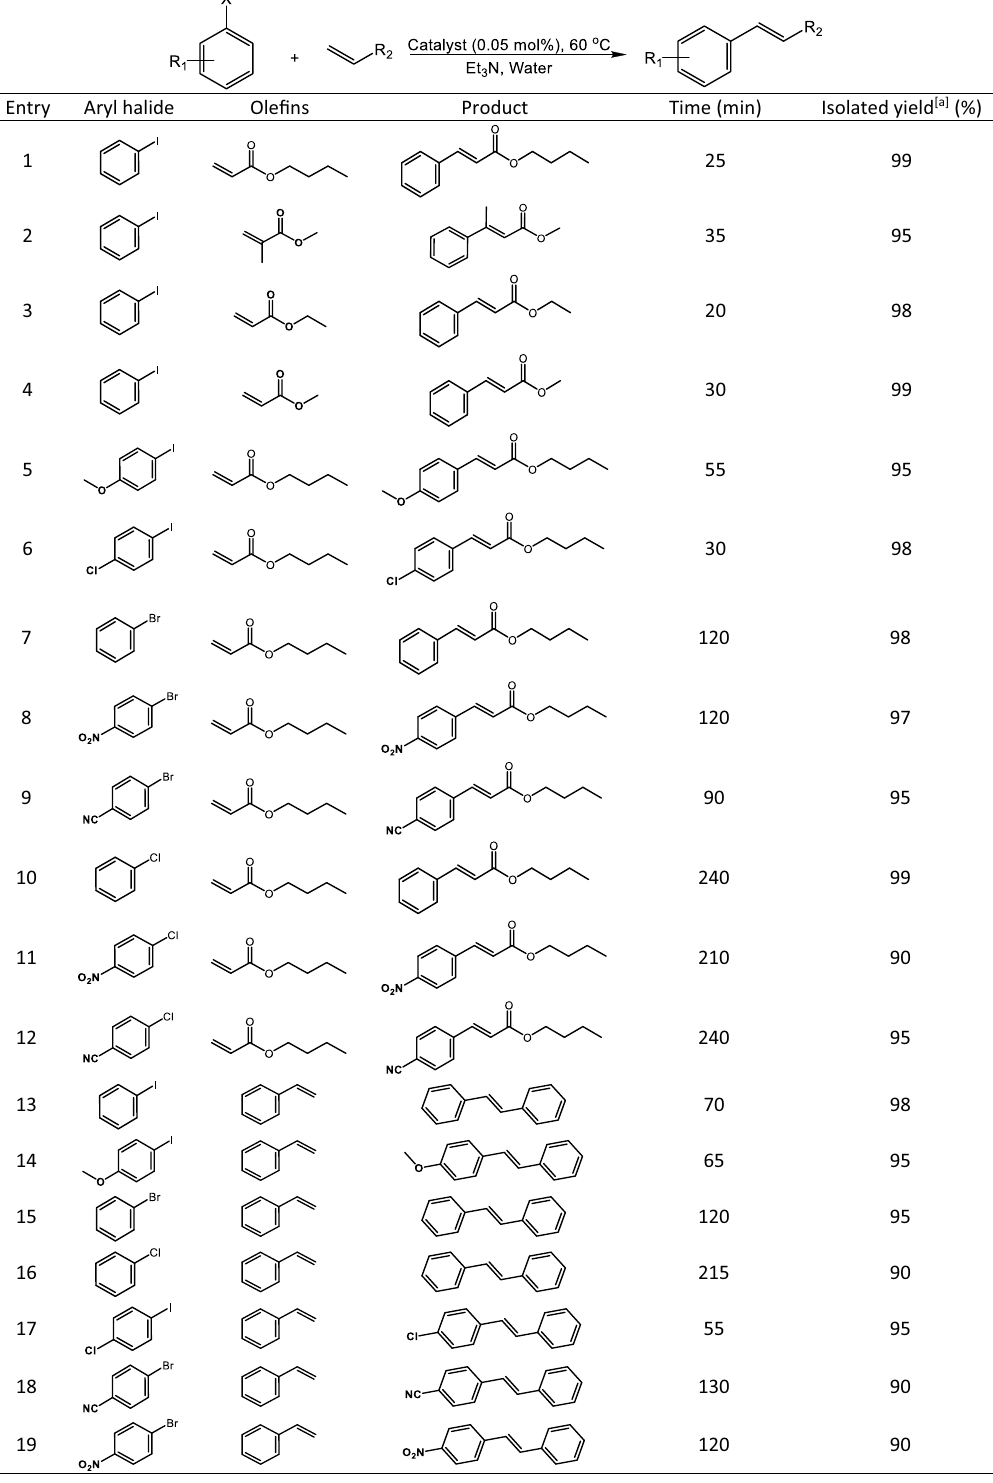
Table 3. Mizoroki–Heck reaction of various haloarenes with olefins promoted by γ-Fe 2 O 3 @MBD/Pd-Co in aqueous media. [a] Reaction conditions: catalyst (0.05 mol% based on the Pd content), haloarene (1